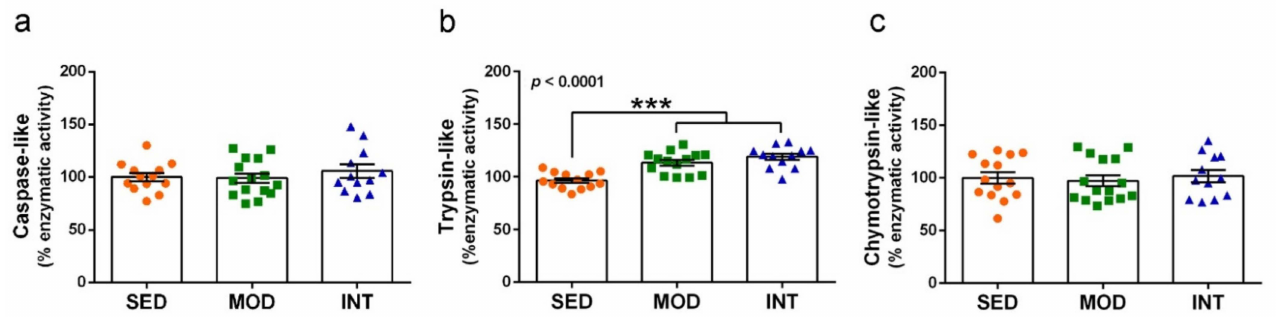
Figure 7. Proteolytic activity of the proteasome was increased by exercise. Caspase-like enzymatic activity ( a ), trypsin-like activity ( b ), and chymotrypsin-like activity ( c ) were determined in cerebral cortical tissue. Experimental groups: SED (orange circles), sedentary; MOD (green squares), moderate training; INT (blue triangles), high-intensity training. Values are mean ± SEM (( a ) SED n = 13, MOD n = 15, INT n = 12; ( b ) SED n = 13, MOD n = 14, INT n = 12; ( c ) SED n = 14, MOD n = 15, INT n = 12). Statistics: There was a significant ANOVA effect of exercise treatment in ( b ) with post hoc test *** p < 0.001 for both MOD and INT in comparison to the SED group.